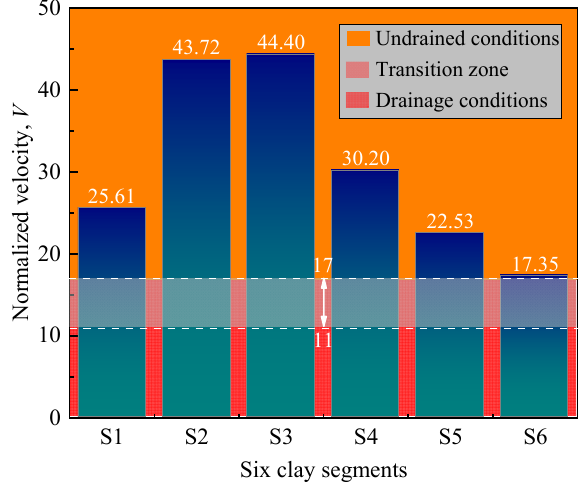
Figure 6. Normalized velocity for each sediment segment.